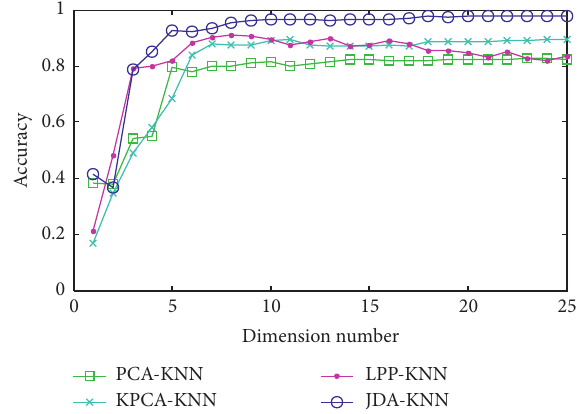
Figure 13: Diagnosis results of Case 3 by using PCA, KPCA, LPP, and JDA under different dimension numbers.